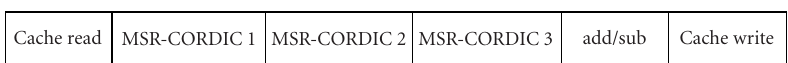
Figure 9: Six-stage cache-PE-cache pipelining scheme.